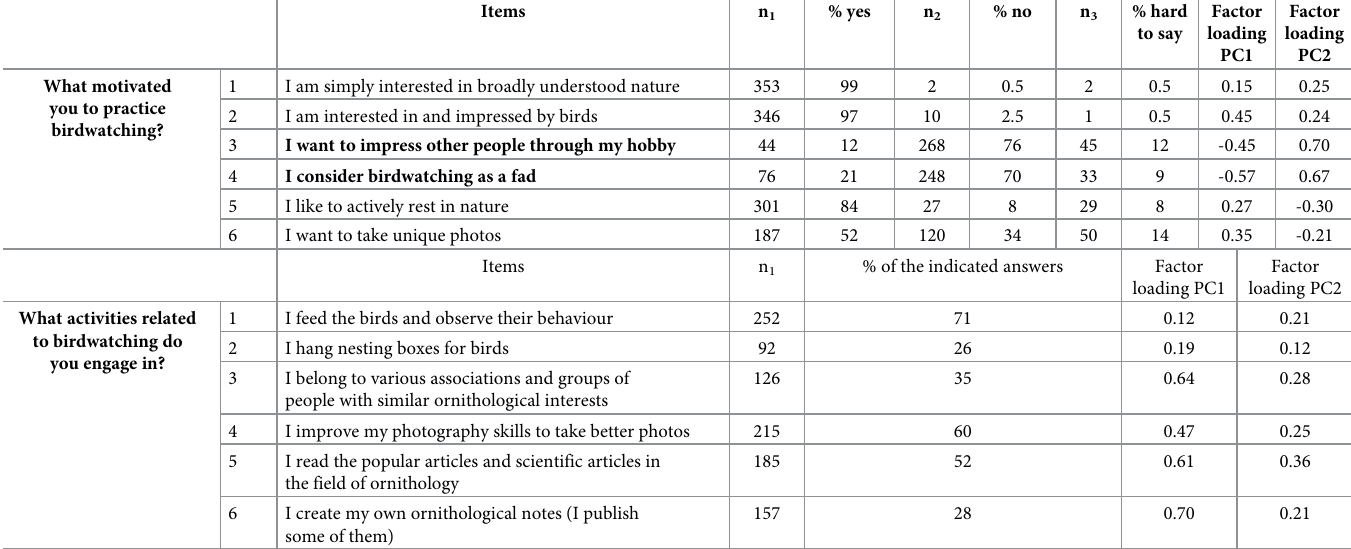
Table 1. Birdwatchers’ responses to statements about their motives and activities performed for